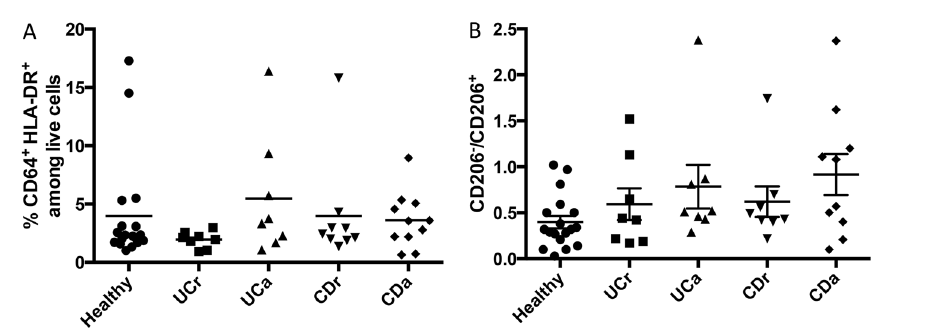
Figure 5. Intestinal macrophages in health and disease. ( A ) Proportion of total macrophages (CD64 + HLA-DR +) inthe lamina propria of healthy colonic tissue, and tissue isolated from CD and UC patients. ( B ) Ratio of CD206 − :CD206 + macrophages. UCr UC tissue in remission, UCa active (inflamed) UC tissue, CDn CD tissue in remission and CDd active (inflamed) CD tissue. Sample numbers are n = 18, 8, 8, 9 and 10 for Healthy, UCr, UCa, CDr and CDa,